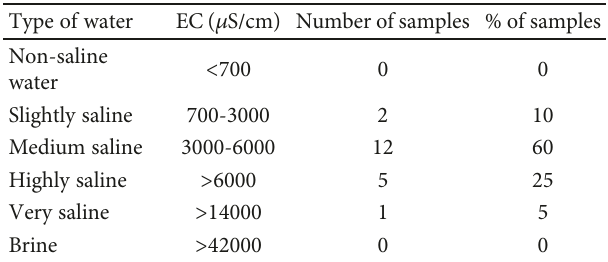
Table 7: Groundwater classi fi cation according to electrical